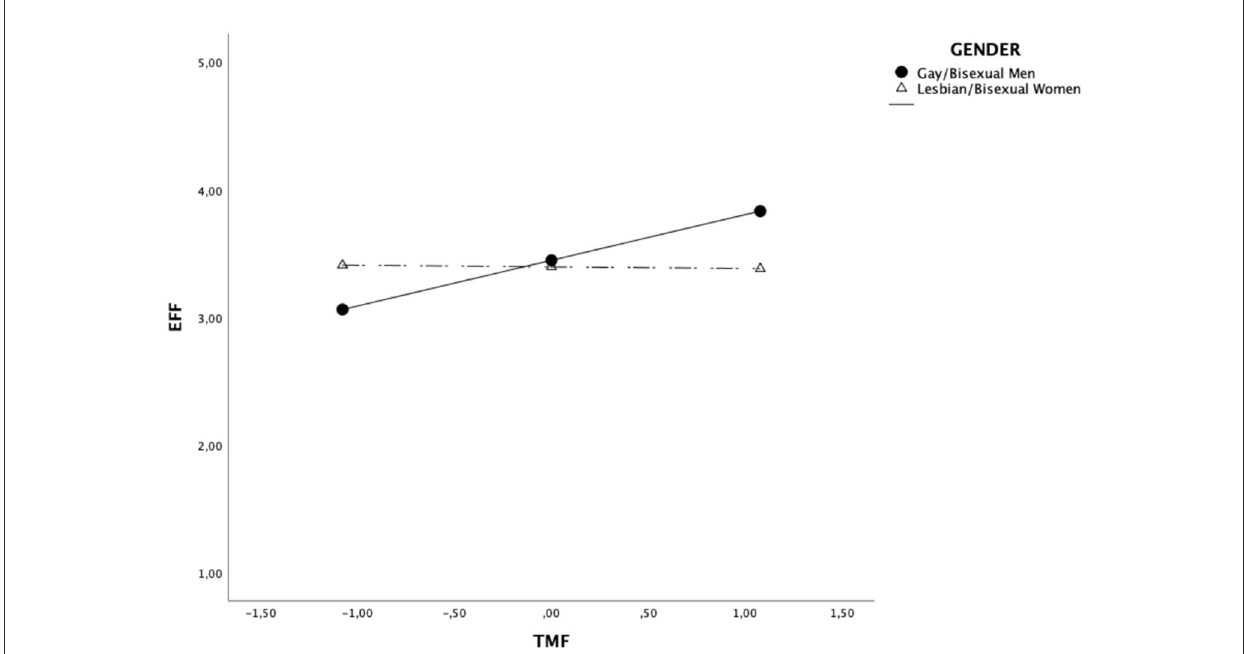
FIGURE1 Simple slopes analyses of the interaction TMFxGender on EFF. EFF, Self-perceived leadership effectiveness; TMF, Traditional Masculinity-Femininity Scale: Higher scores correspond to higher traditional